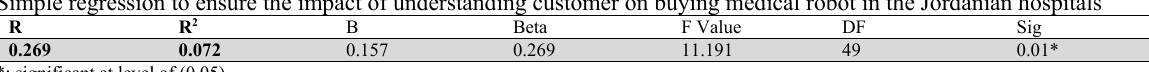
Simple regression to ensure the impact of promotion on buying medical robot in the Jordanian hospitals R R 2 B Beta F Value DF Sig 0.299 From Table 6 it is observed that there is a significant impact of promotion on buying medical robot in the Jordanian hospitals. The R was (0.299), whereas the R 2 was (0.089). This means the (8.9%) of promotion impact on buying medical robot in the